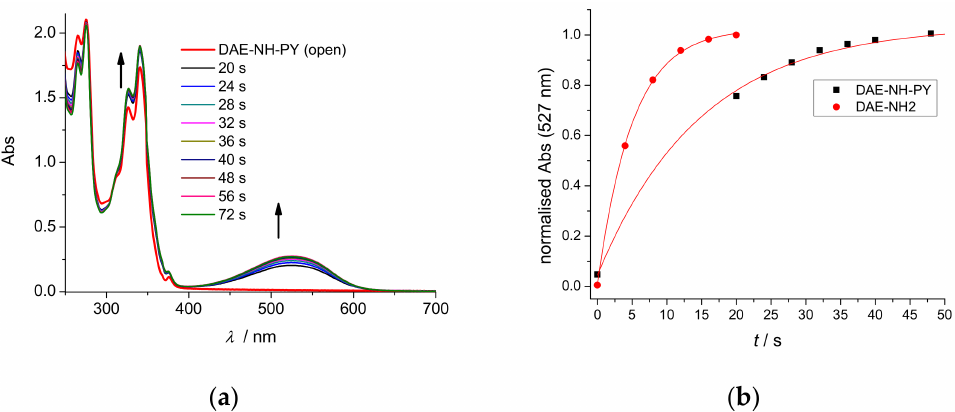
Figure 2. ( a ) Changes in UV/Vis spectra of DAE-NH-Py ( c = 1.0 × 10 − 4 M) during 32 W lamp, 254–315 nm range irradiation ( t tot . = 72.00 s) in MeOH (4.3% DMSO); ( b ) Normalized Abs changes for DAE-NH-Py and DAE-NH 2 at λ = 527 nm as a function of irradiation